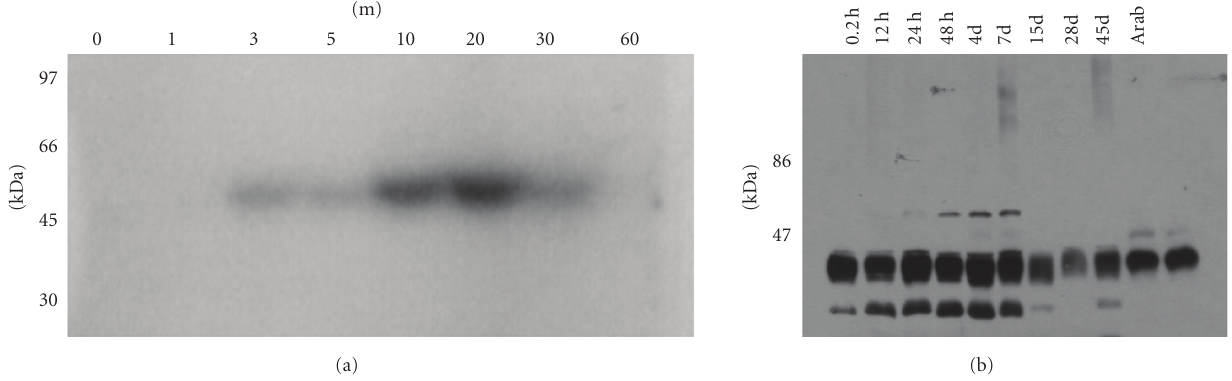
Figure 2: (a) Detection of MBP Kinase Activity in hop extracts at di ff erent time points (T0, T1, T3, T5, T10, T20, T30, and T60min) immediately after wounding. In in-gel kinase assays MAPK phosphorylates MBP. A band of approximately 50 kDa was induced upon wounding of hop internodes. (b) MAPK 6 activity during hop organogenesis (T0, T2h, T12h, T24h, T48h, T4d, T7d, T15d, T28d, and T45d). Phosphorylation of MBP was analyzed by autoradiography following immunoprecipitation with MAPK6 antibody. In hop extracts and Arabidopsis (lanes Arab) subjected to in-gel kinase assay, a band of approximately 46-kDa was